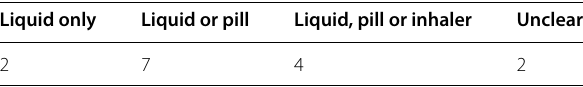
Table 4 Number of participants with differing interpretations of the phrase ‘oral steroids’ Liquid